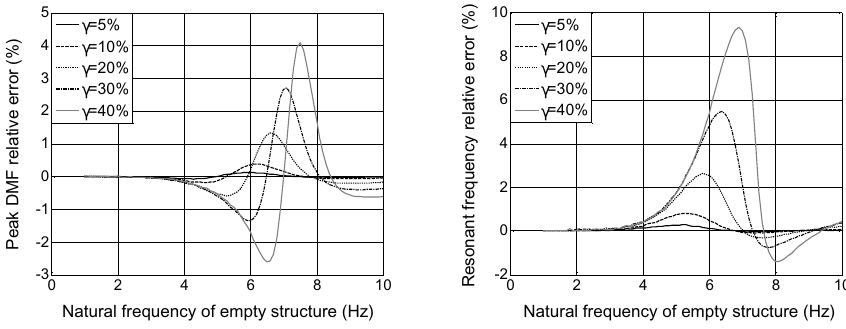
Fig. 7. Peak DMF relative error (left) and resonant frequency relative error (right) for equivalent SDOF